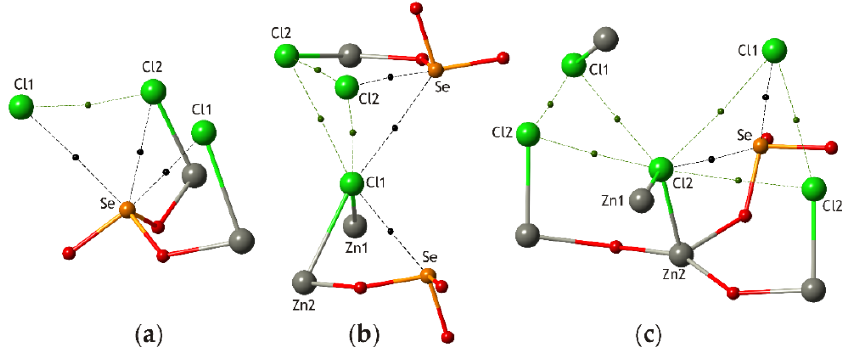
Figure 3. Geometrical environment of bond critical points of weak closed-shell interactions in β-Zn 2 (SeO 3 )Cl 2 : ( a ) The bcps around the Se site; ( b ) The bcps around the Cl1 site; ( c ) The bcps around the Cl2 site. Legend as in Figure 1. Table 3. Bond critical points in the crystal structure of β -Zn 2 (SeO 3 )Cl 2 and their